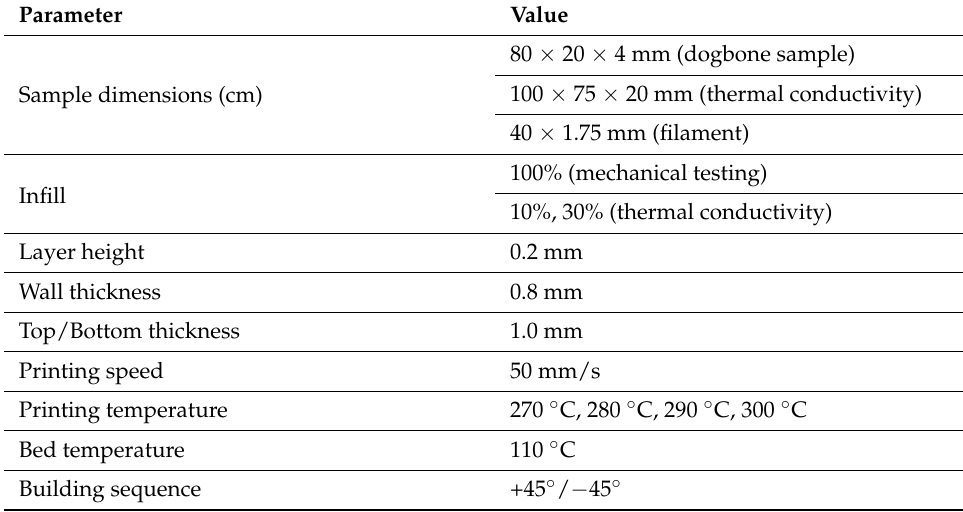
Table 2. Printing setting for PC filament.